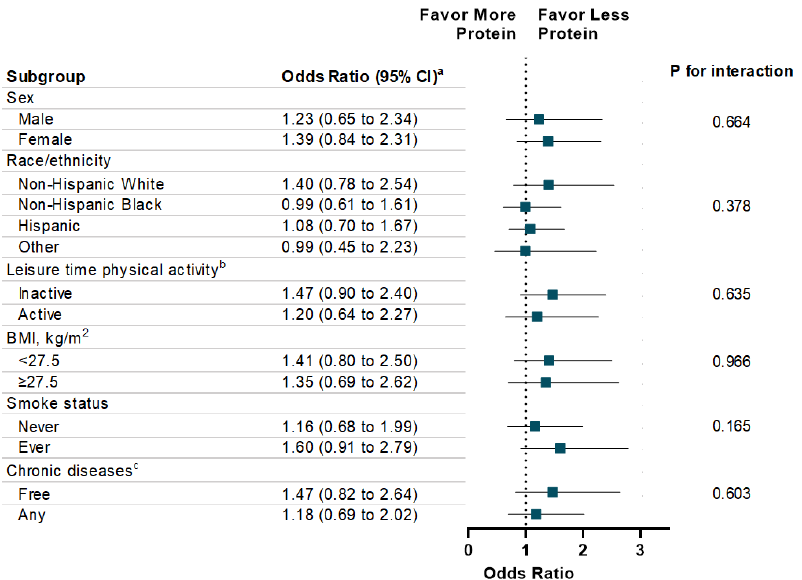
Figure 2. Stratification Analysis on Association Between Energy Intake from Protein and Memory Impairment Among US Adults ≥60 years, NHANES 2011–2014. a Multivariable models were adjusted for age, sex, race/ethnicity, education attainment, and family poverty ratio, physical activity, HEI-2010, alcohol intake, BMI, Body Weight, smoking status, hypertension, hypercholesterolemia, family history of diabetes, history of CVD, and history of cancer. b Leisure-time physical activity level was defined by engaging in no (inactive) or any (active) moderate or vigorous recreational physical activity over the past 30 days. c Chronic Diseases included diabetes, CVD, and Cancer. Nutrients 2020 , 12 , x FOR PEER REVIEW